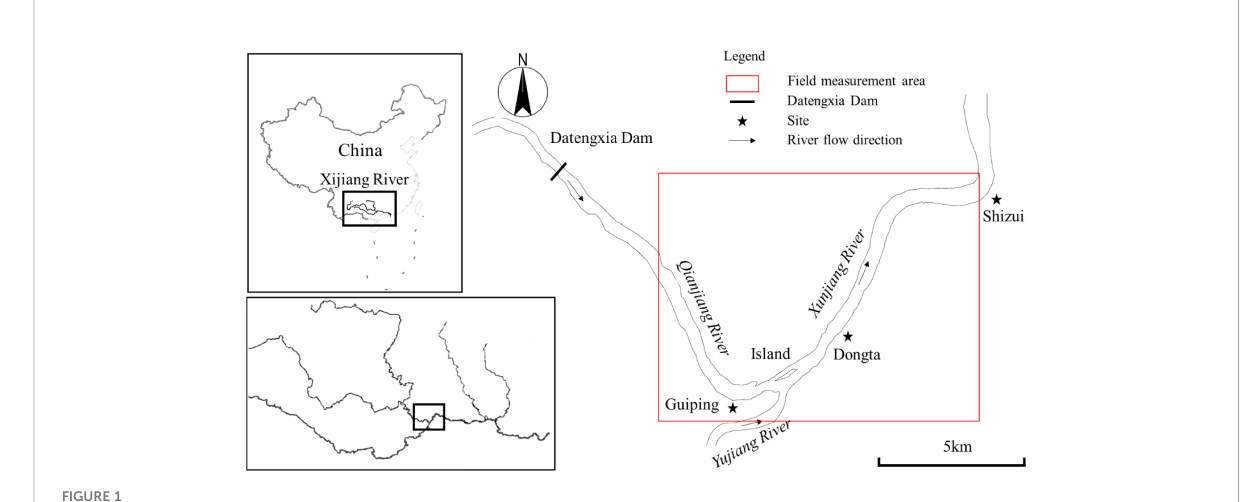
FIGURE 1 Location of the study